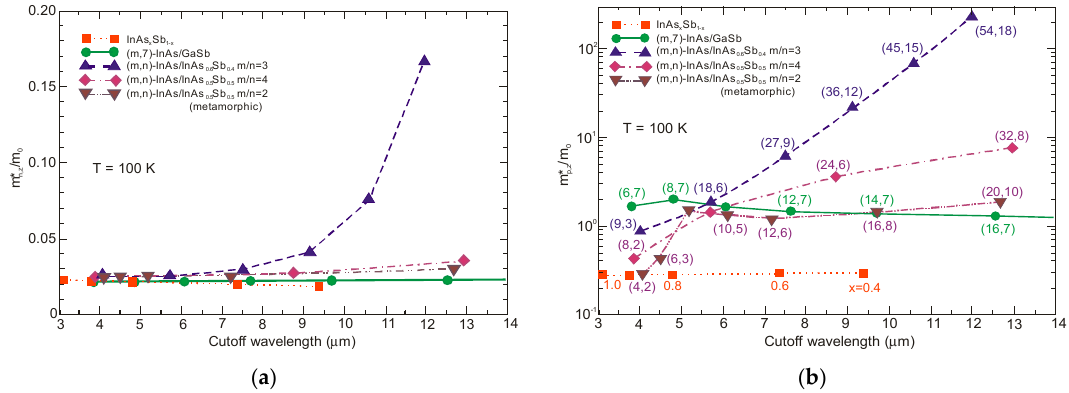
Figure 26. Electron ( a ) and hole ( b ) effective masses along the growth direction versus λ cut-off for Electron ( a ) and hole ( b ) e ff ective masses along the growth direction versus λ ff erent material systems: free-standing bulk InAsSb with varying Sb composition different material systems: free-standing bulk InAsSb with varying Sb composition x , (m,7)- cut-o ff for di InAs/GaSb T2SL, pseudomorphic (m,n)-InAs/InAs 0.6 Sb 0.4 T2SL on GaSb substrate, pseudomorphic x , (m,7)-InAs / GaSb T2SL, pseudomorphic (m,n)-InAs / InAs 0.6 Sb 0.4 T2SL on GaSb substrate, (m,n)-InAs/InAs 0.5 Sb 0.5 T2SL on GaSb substrate and (m,n)-InAs/InAs 0.5 Sb 0.5 T2SL on a metamorphic pseudomorphic (m,n)-InAs / InAs 0.5 Sb 0.5 T2SL on GaSb substrate and (m,n)-InAs / InAs 0.5 Sb 0.5 T2SL substrate with lattice constant 0.4% larger than that for GaSb (after [107]).